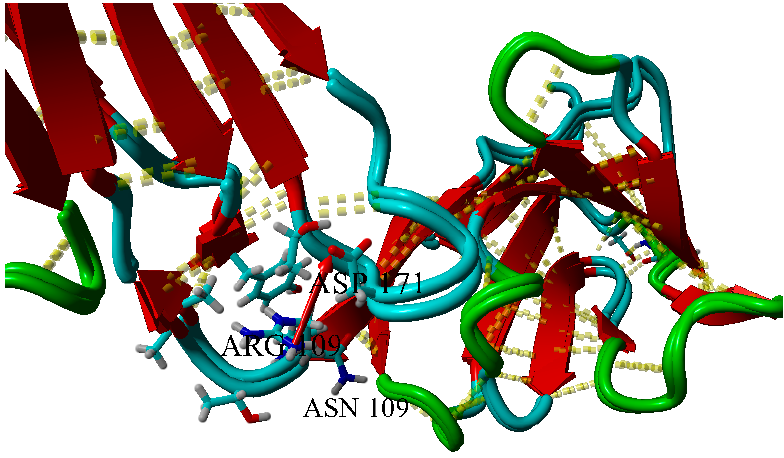
Figure 8. Superposition of wild-type and R109N variants of BIF. The red arrow shows a weak (d = 5.969 Å) ionic pair. 3D dashed lines show hydrogen bonds.